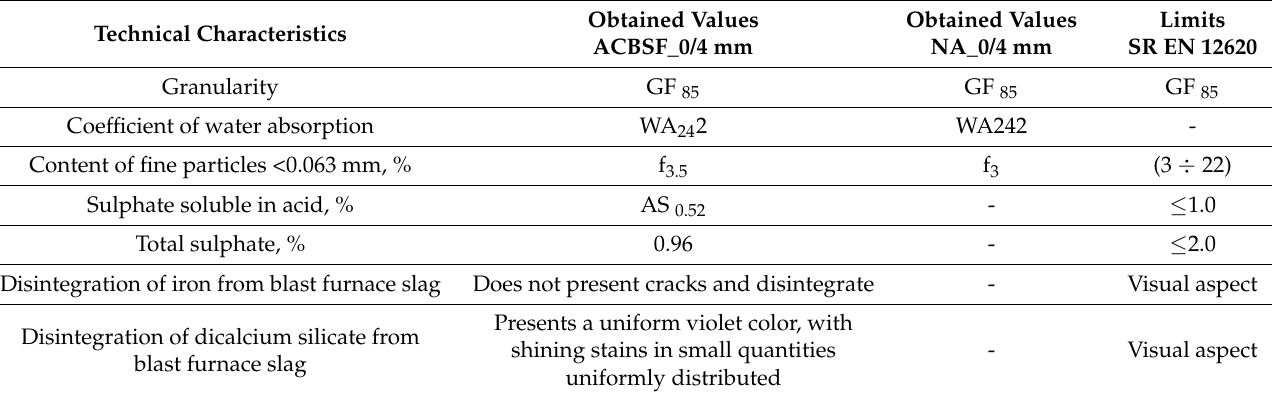
Table 2. Characteristics of natural sand (NA) and of aggregates from blast furnace slag (ACBFS), 0/4 mm. Technical